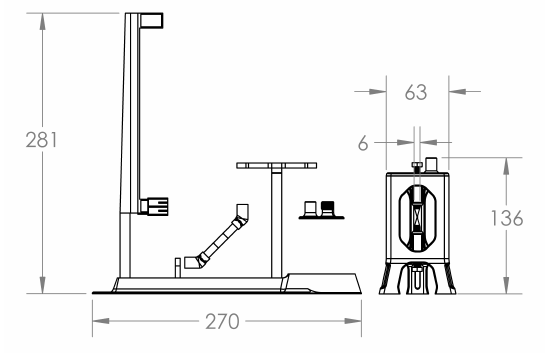
Figure 9. Measurement system and cell